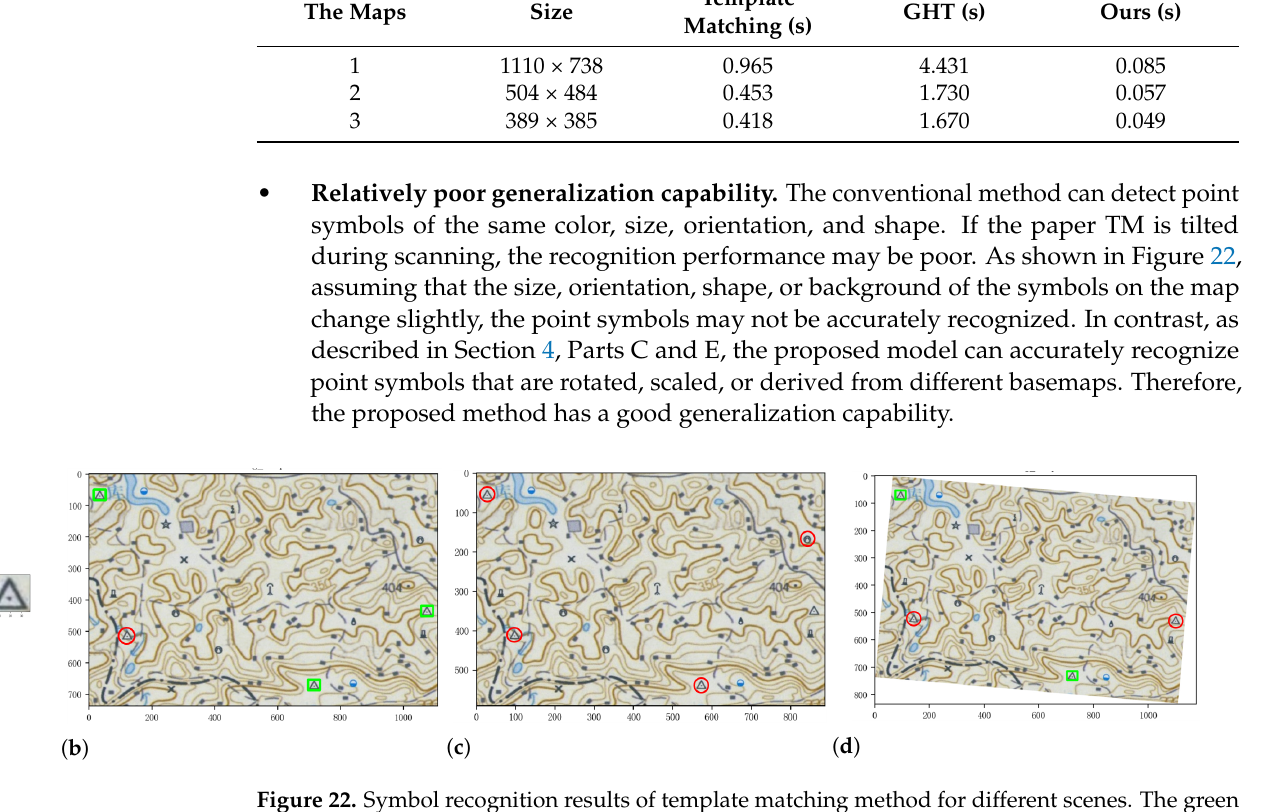
Figure 22. Symbol recognition results of template matching method for different scenes. The green box indicates correct recognition, whereas the red circle indicates missed recognition. ( a ) Template. ( b ) Results for different map backgrounds. ( c ) Results for 0.8 times smaller size. ( d ) Results for 5° angle